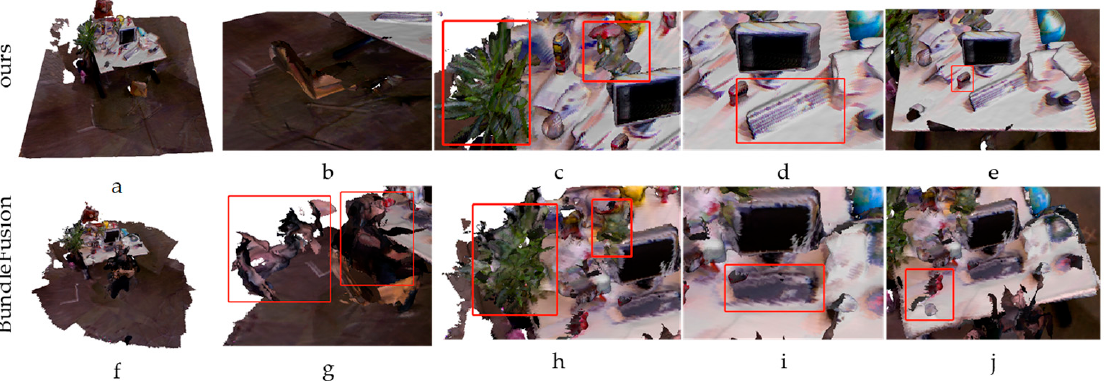
Figure 6. Top: the reconstruction result obtained by the proposed method. Bottom: the reconstruction result obtained after filtering out the dynamics and inputting it directly into BundleFusion. ( a , f ) are the reconstruction effects of the proposed method and BundleFusion, respectively. ( g ) is a sequence scene in which the moving people are not cleanly filtered out, and the corresponding figure ( b ) can filter out the moving people. ( c ) is a clearer reconstruction of the potted plants in the sequence than figure ( h ). ( d ) is the position of the keyboard after it is moved by a human, while ( i ) is the position before the keyboard is moved. The position of the keyboard in ( e ) is the position of coke after it is moved, while the position tracking failure of ( j ) for coke leads to the reconstruction of a coke bottle with continuous fragments, similar to the tracking effect of figure g for people.